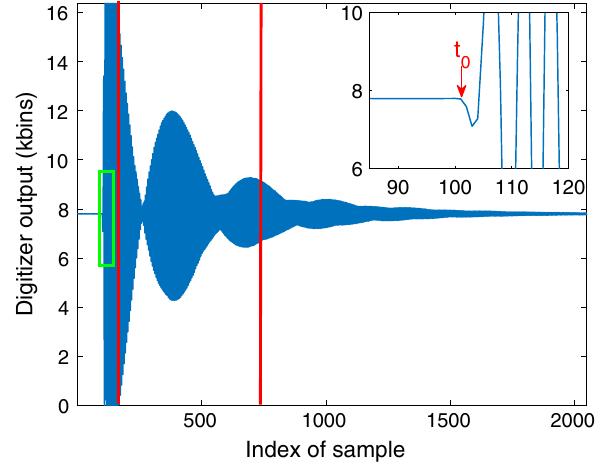
FIG. 7. Example of a saturated waveform measured from cavity seven. Two red lines select the part of the waveform used for further analysis. The small window shows a magnified view of the green rectangle. We define t 0 , at the sample index of 101, as the signal start time.